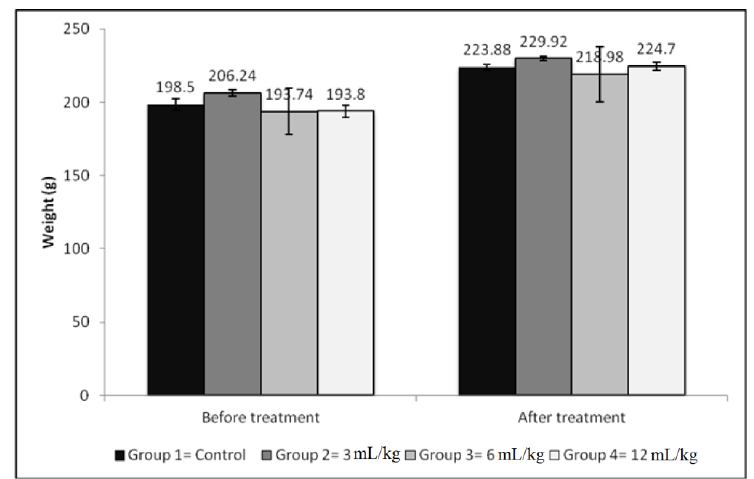
Figure 3. Body weight changes before and after 14-days treatment with Plantago syrup. The treated and controlled groups showed normal weight gain. There were no significant differences in average weights between the treated groups and control groups ( p > 0.05). Values represent the average weight of five rats ± SD. Table 4. Weight of both kidneys and liver in control and 14-day treated groups with Plantago syrup. Weight (g)